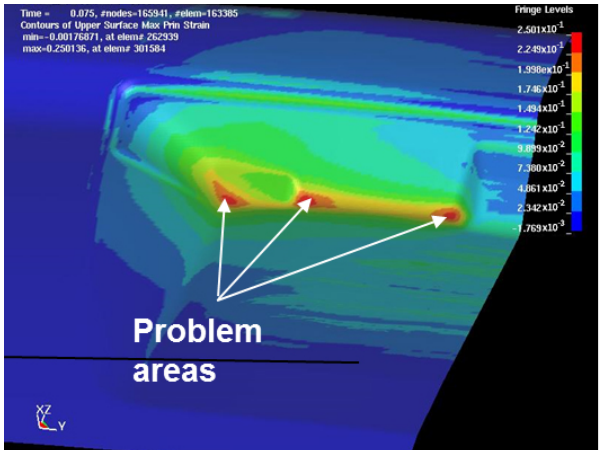
Figure 3. Results of quasistatic numerical simulation of forming a sheet metal blank with uniformly distributed